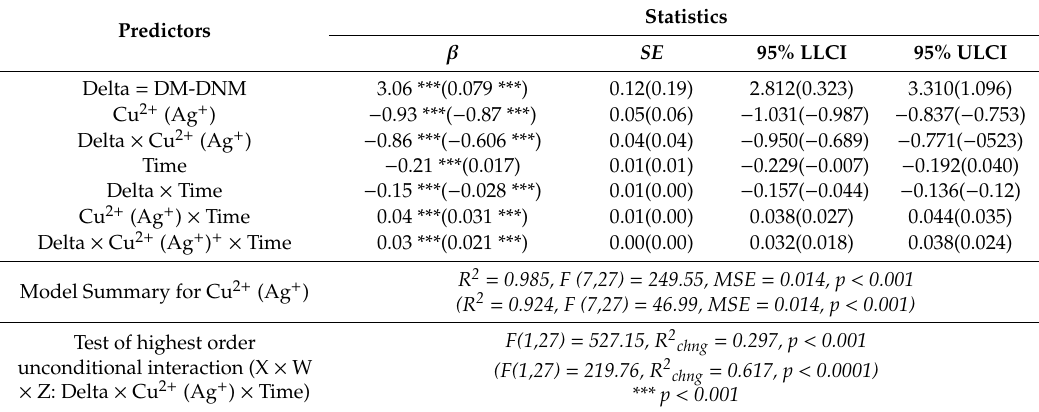
Table 2. The moderated moderation model showing three-way interaction among Delta, Time of in vitro tissue cultures and Cu 2 + (Ag + ) ion concentration on the number of green plants regenerated via anther cultures. β reflect standardized e ff ects; LLCI and ULCI indicate confidence intervals (LLCI -lower, UPLCI upper) whereas SE is a standard error of β